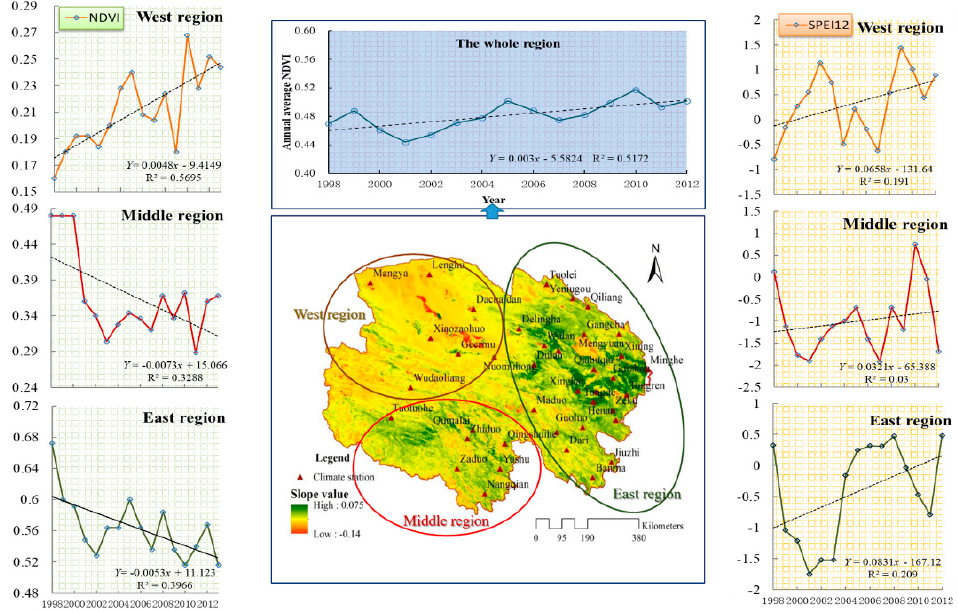
Figure 6. Slope values and annual change of NDVI in different locations in Qinghai Province.